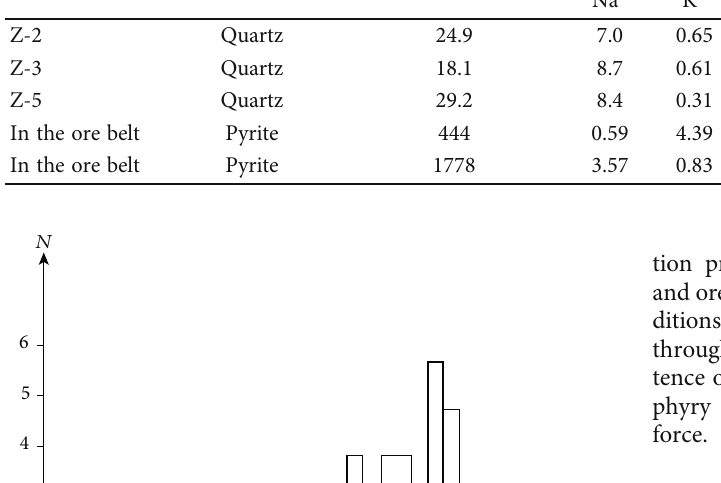
Table 4: Component contents of inclusions in Zhacun goldmine. Sample no.